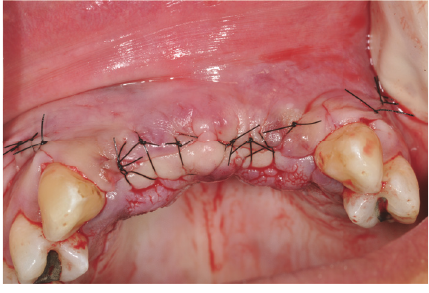
Figure 7: Ceramic